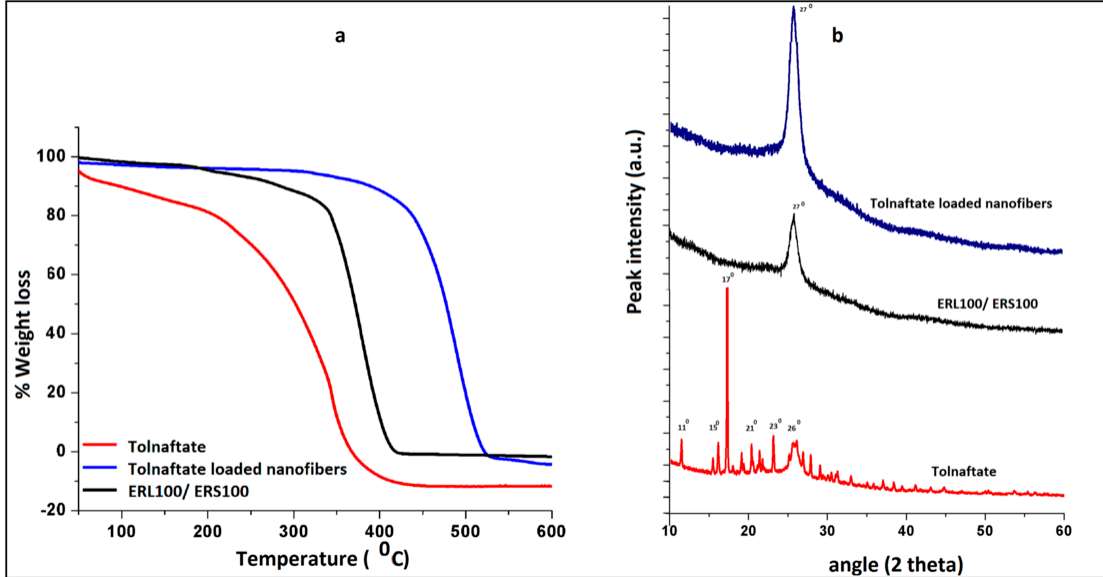
Figure 4. TGA portrait revealing thermal behavior of polymers ERL100/ERS100, tolnaftate, and tolnaftate-loaded nanofibers ( a ). Comparative PXRD portrait of ERL100/ERS100, tolnaftate, and tolnaftate-loaded nanofibers ( b ).